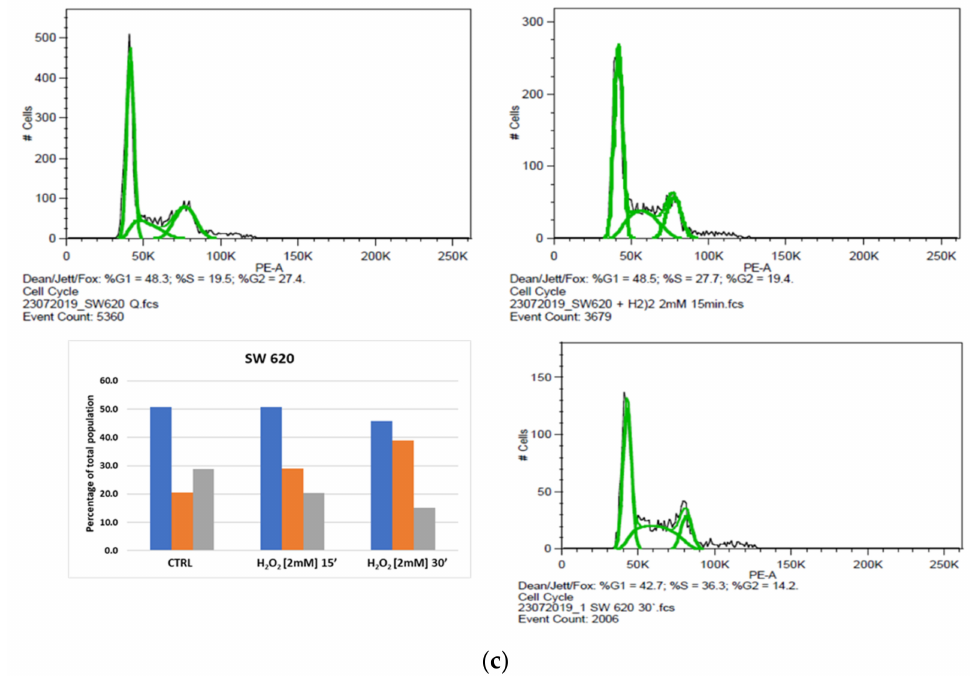
Figure 5. Effect of acute oxidative distress on the cell cycle of starved colon cancer cell lines. Profile analysis and relative percentages in cell cycle stages: ( a ) HCT116, ( b ) SW480, ( c ) SW620. Representative plots of FACS analysis of HCT116, SW480 and SW620 cells, untreated and 15 or 30 min after treatment with 2 mM H 2 O 2 . Graphics indicate percentages of cells in each phase of the cell cycle. Blue bars represent G1/G0 phase, orange bars represent S phase and gray bars represent G2/M